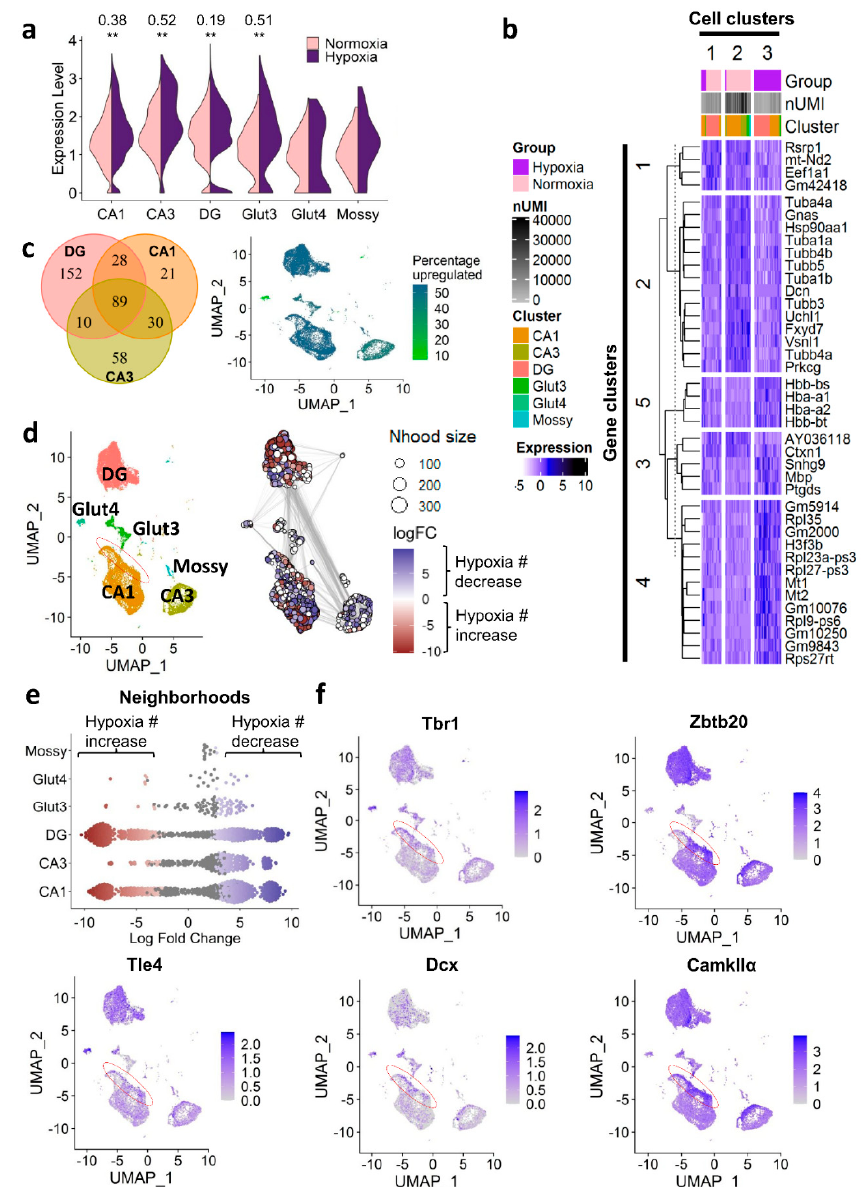
Figure 6. Response of hippocampal excitatory neurons to hypoxia evaluated by scRNA-seq. ( a ) Upregulation of CaMKII α under hypoxia (five days, 6% O 2 for 6 h/day) in excitatory neurons of the hippocampus. ( b ) Heatmap of top 20 upregulated and top 20 downregulated genes under hypoxia. Columns represent cells, rows represent genes. Scaled normalized expression shown. Cells and genes were clustered using the k-means algorithm. Number of unique molecular identifiers per cell: nUMI. ( c ) Left panel: Venn diagram depicting number of shared and uniquely regulated genes under hypoxia amongst excitatory neurons of different hippocampal regions (CA1, CA3, dentate gyrus). All clusters were randomly down-sampled to n = 2296 cells for better comparability. Right panel: Percentage of upregulated genes amongst all hypoxia-regulated genes; |log-fold change| > 0.25, p -adj < 0.05, correlation-adjusted Wilcoxon test. ( d ) Differential cell abundance testing with MiloR [20]. Red (= negative logFC) represents a numerical increase upon hypoxia in the respective neighborhood, blue (= positive logFC) indicates a decrease. Region marked in red specifies region of immature and intermediately mature neurons of CA1 increased in number under hypoxia. logFC: log-fold change, Nhood size: neighborhood size. ( e ) Beeswarm plot showing the numerical increases and decreases under hypoxia in the respective neighborhoods of each cell cluster. Red (=negative logFC) indicates an increase under hypoxia, blue (= positive logFC) a decrease. ( f ) Expression of immature and intermediately mature excitatory neuron markers. Red oval indicates again the interesting region denoted in ( d ) with increase in cell abundance upon